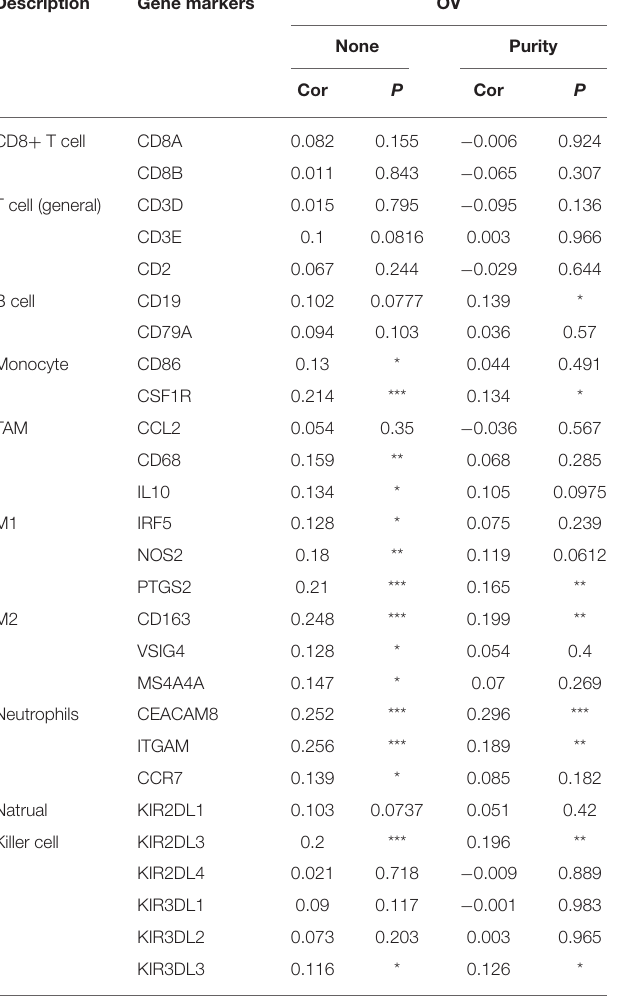
TABLE 4 | Correlation analysis between PER1 and immune cell markers. Description